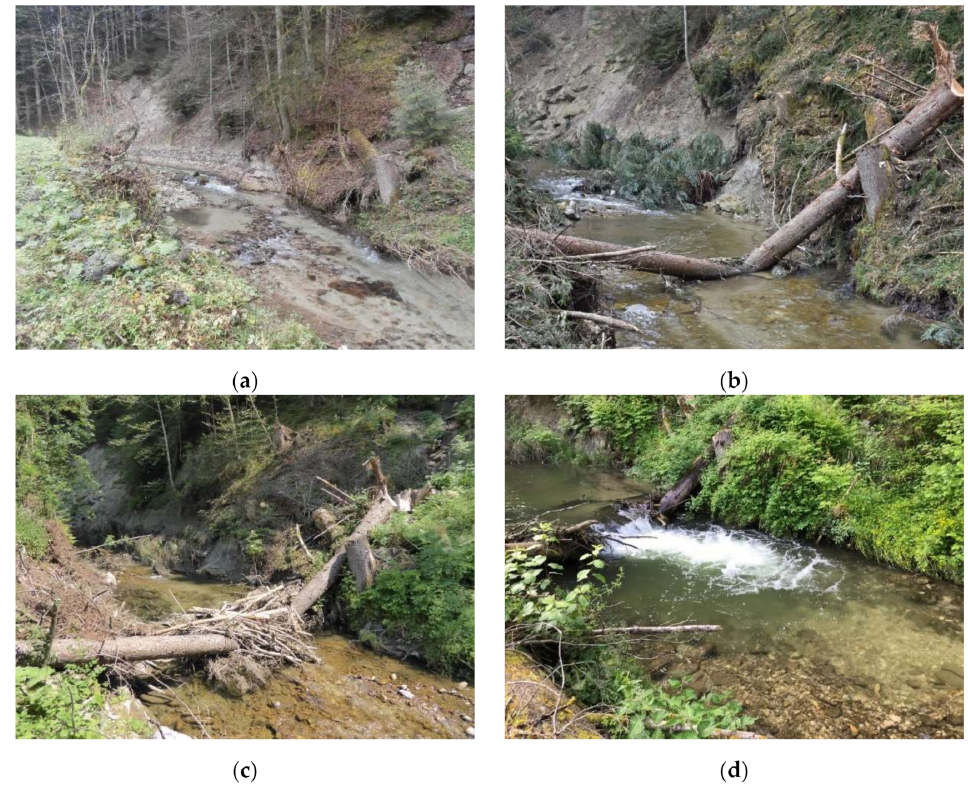
Figure 1. Evolution of an introduced LWS in the span of 2 years ( a ) before the restoration; ( b ) shortly after introduction; ( c ) after approx. 6 months; and ( d ) after 2 years; Scherlibach stream; Photos: M.